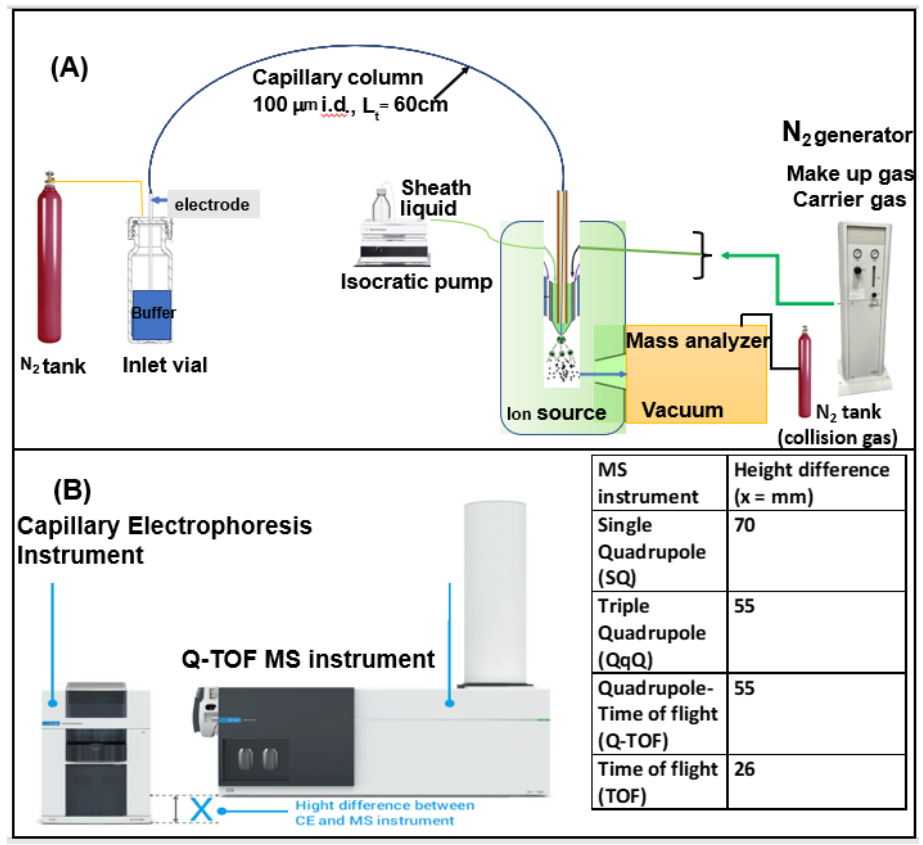
Figure 4. A general illustration of the CE-MS instrument arrangement shows: ( A ) experimental set-up equipped with a sheath liquid pump, an orthogonal ESI source, make-up carrier gas, and collision gas supplied by a nitrogen generator and a nitrogen tank, respectively; ( B ) positioning the bench to adjust the sprayer height above bench level (X). The inset table on the right specifies height adjustments for different mass analyzer types (the graphics are courtesy of Agilent Technologies). ( A ) is reproduced with permission from A. S. M. Mojibur Rahman Chawdhury (dissertation in preparation) at Georgia State